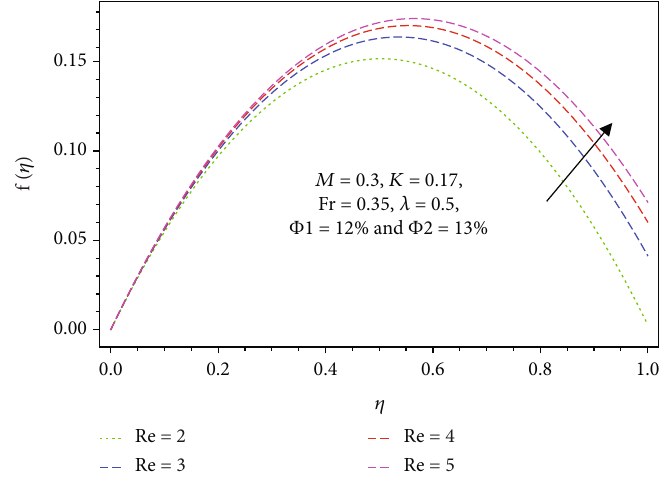
Figure 6: Impact of Reynolds number Re over momentum pro fi le f ð η Þ .